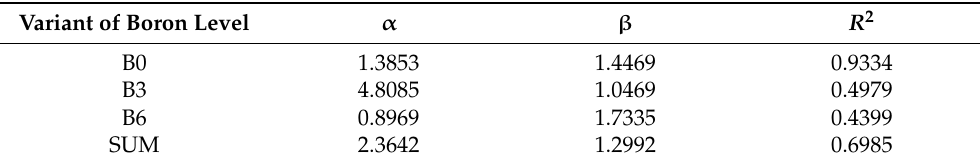
Table 6. The estimations of parameters ( α and β ) of the exponential function for the three levels of boron supply (B0, B3, and B6) and for the entire dataset (SUM), written as y = α e β x + ε , where independent variable ( x ) is nitrogen content in pine needles (CN), dependent variable ( y ) is arginine content in needles (CArg), ε is error, and R 2 is the coefficient of